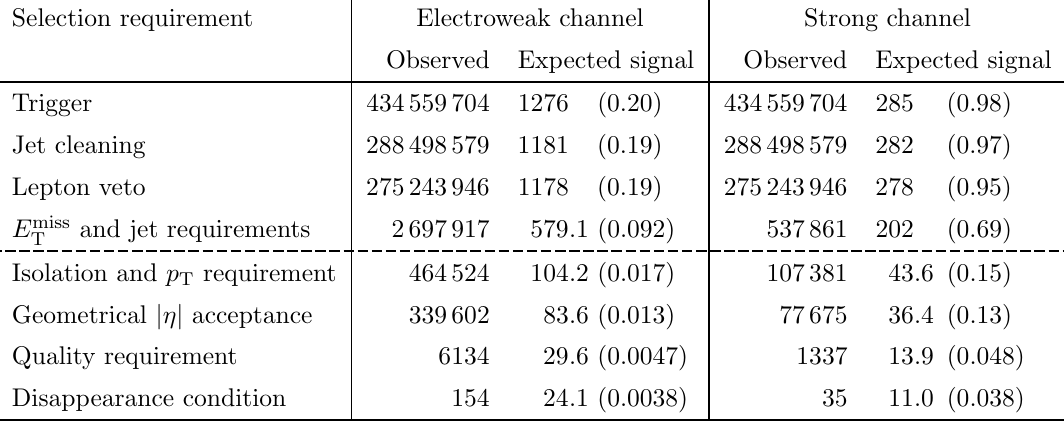
; (cid:28) ) = (400 GeV ; 0 : 2 ns) and a ~ (cid:31) (cid:6) 1 ~ (cid:31) (cid:6) 1 ; (cid:28) ) = (1600 GeV ; 500 GeV ; 0 : 2 ns) in the ~ (cid:31) (cid:6) 1 ~ (cid:31) (cid:6) 1